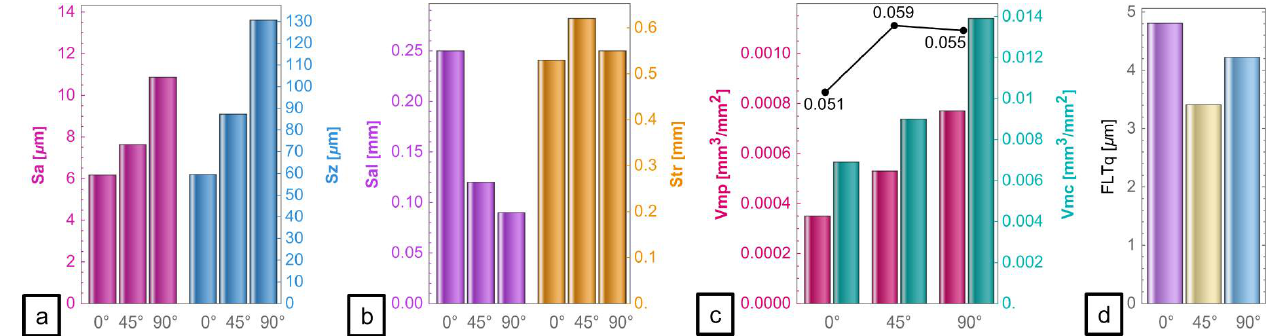
Figure 13. Areal roughness parameters for investigated building orientations: Sa vs. Sz ( a ), Sal vs. Str ( b ), Vmp vs. Vmc, and Vmp-to-Vmc ratio ( c ), and FLTq ( d ).